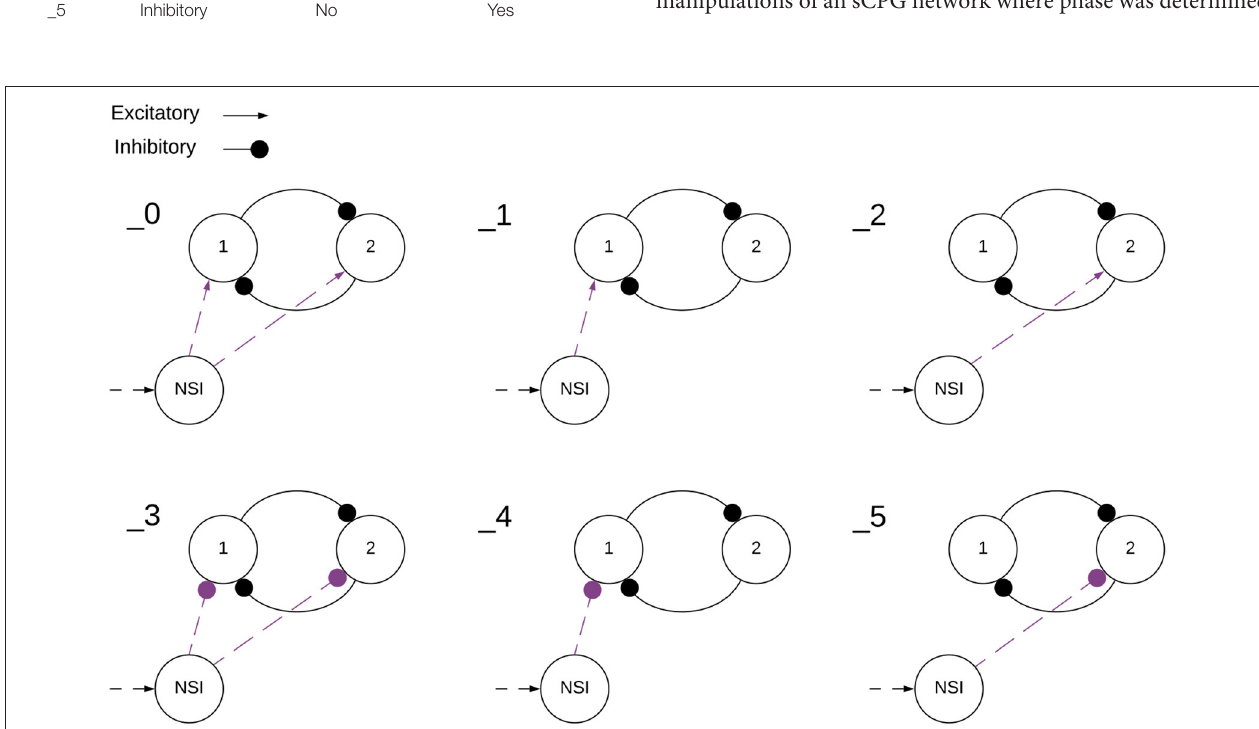
FIGURE 5 | Visualization of NSI communication testing subcategories outlined in Table 2 . Arrows are excitatory and solid circles are inhibitory connections. The connection may be a current injection, a voltage characteristic manipulation, or both depending on the main test number found in Table 1 . This visualization shows how the subcategories determine the input to the sCPG populations. The numbers indicate the test subcategory corresponding with the depicted setup.